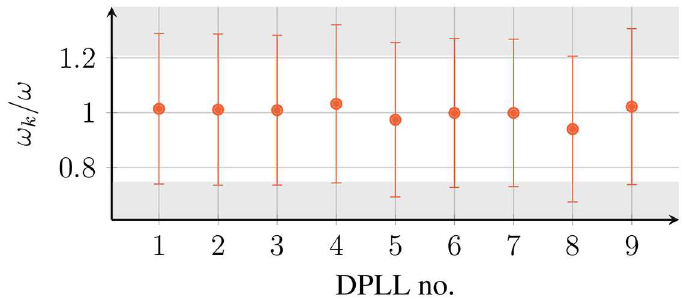
Fig 8. Dynamic frequency range of all 9 DPLLs specified in Table 1. Red dots indicatethe intrinsic frequency ω , bars indicate the frequency range where the VCO responseis linear (see Fig 2). Shaded areas indicatethe system’s clippingregions; outside these regions the responseof all VCOs is linear.